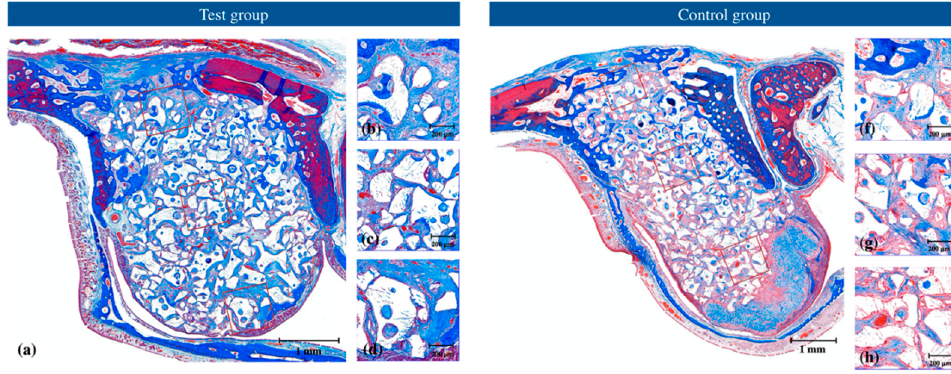
Figure 4. Representative histological views at 4 weeks with Masson’s trichrome staining of the ( a – d ) test and ( e – h ) control ( a , e ) groups showing total augmentation, ( b , f ) region of interest close to the surgical access window, ( c , g ) region of interest at the center of augmentation, and ( d , h ) region of interest close to the Schneiderian membrane.